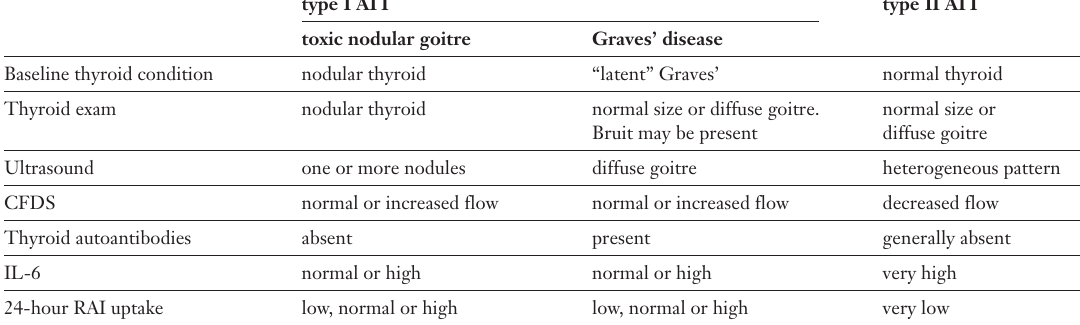
Types of AIT, based on the clinical exami- nation, investigations and baseline thyroid